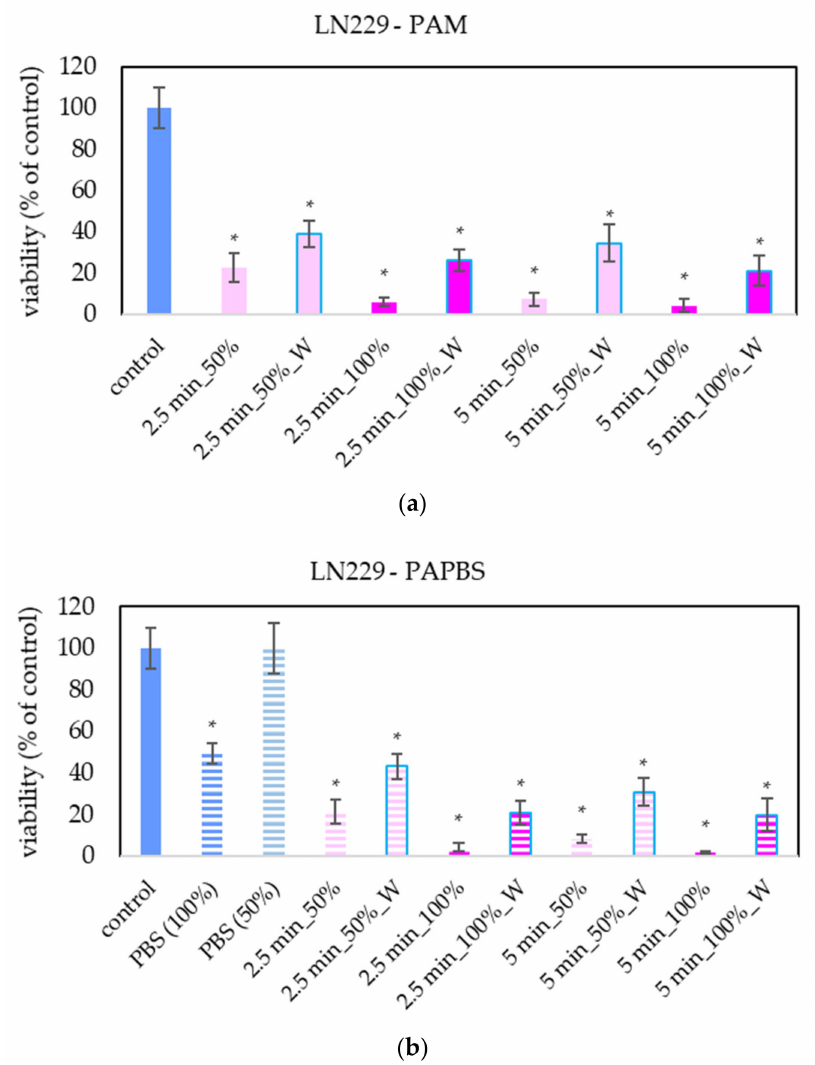
Figure 6. Effect of PAL on cell viability of glioblastoma cells LN229 24 h after PAL application. Plasma-activated medium (PAM) ( a ) or plasma-activated PBS (PAPBS) ( b ) activated for 2.5 and 5 in 100% or 50% concentration were used. Time of PAL action was 24 h (without blue frames) or 30 min, after which PAL were replaced with untreated medium (W, blue frames). The significant results ( p < 0.05) are marked with *. Significance of 100% PAPBS, resp. 50% PAPBS was tested compared to in 100% PBS, resp. 50% PBS, significance of other samples compared to control. Viability was normalized to the control cells incubated in the